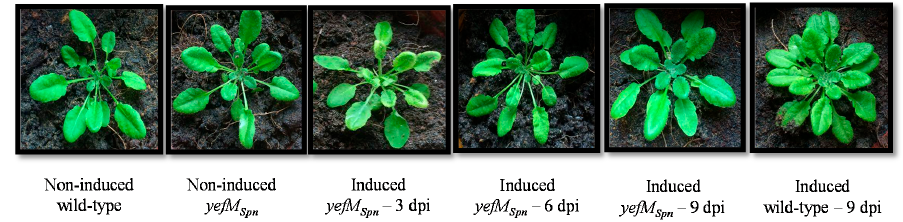
Figure 3. Four-week-old T 2 transgenic A. thaliana plants harboring the yefM Spn transgene 3, 6 and 9 days post-induction (dpi) with 17- β -estradiol. Also depicted are non-induced wild-type A. thaliana , non-induced transgenic A. thaliana ( yefM Spn ) and induced wild-type A. thaliana applied with 17- β -estradiol at nine days post-induction.